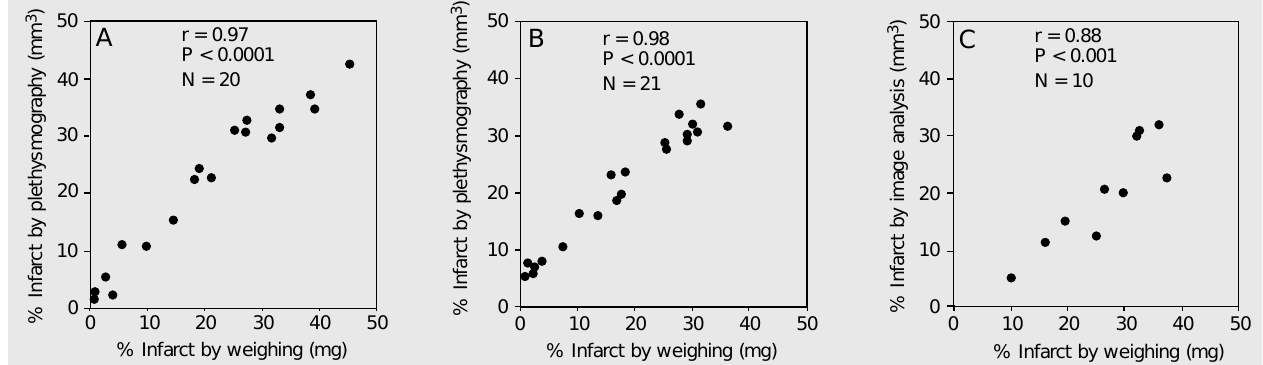
Figure 2. Influence of duration of medial cerebral artery (MCA) oc- clusion on infarct size (panel A) and core temperature (panel B). Data are the means ± SEM and the number of animals studied in each group is given in parenthe- ses. Infarct size was estimated by dissecting and weighing the ischemic tissue which is reported as a percent of the affected hemi- sphere. Infarct size increased with duration of ischemia (P < 0.005). During ischemia, hyper- thermia developed at the end of each occlusion period (*P < 0.001-0.0001 vs basal,